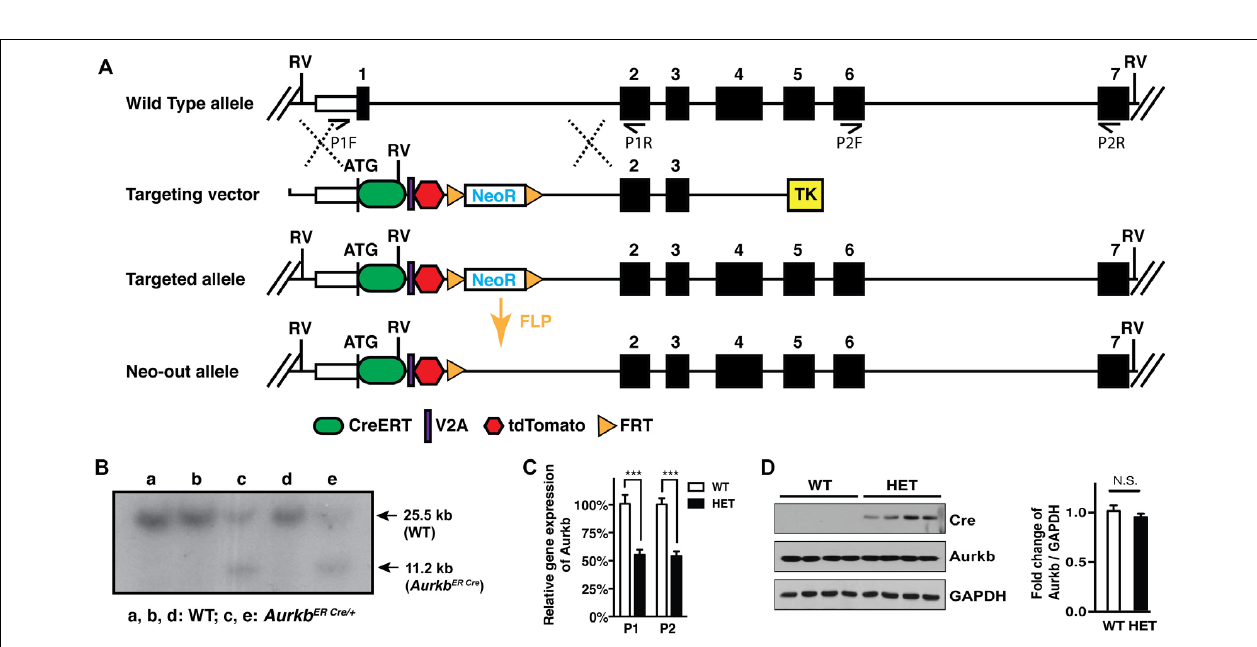
Frontiers in Cell and Developmental Biology |